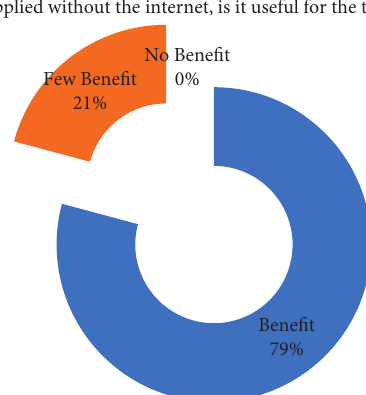
Figure 5: The intention of ICT-based media without